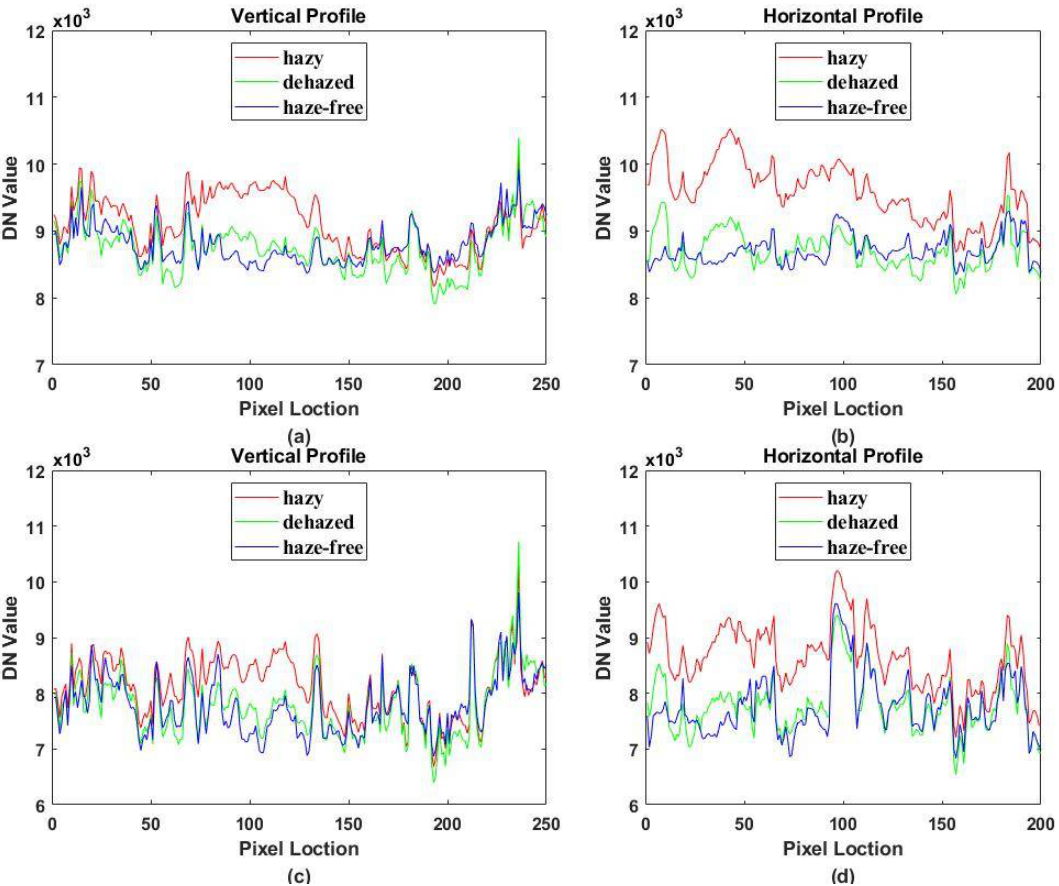
Figure 18. Band profiles taken from hazy (red line), dehazed (green line) and haze-free (blue line) images. The location is marked by the red cross in Figure 8a. ( a ) vertical profile of blue band (0.483 μm); ( b ) horizontal profile of blue band; ( c ) vertical profile of red band (0.655 μm); ( d ) horizontal profile of red band.